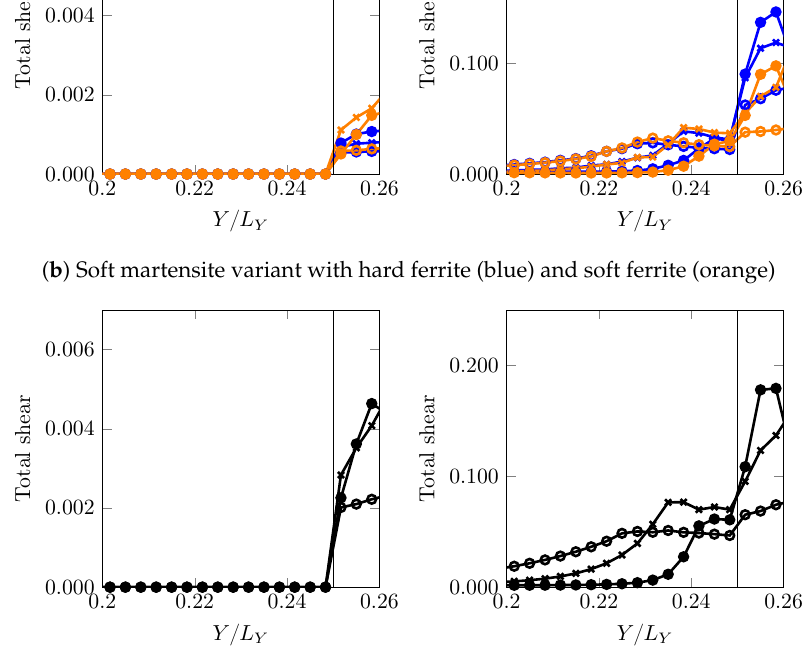
Figure 9. Total shear distribution profiles (along X = at ( 0,0.25 L Y ) and extending into the ferrite zone) profiles for different martensite variant-ferrite combinations at two different overall deformation levels, ¯ F 11 = 1.00125 ( left column) and ¯ F 11 = 1.00875 ( right